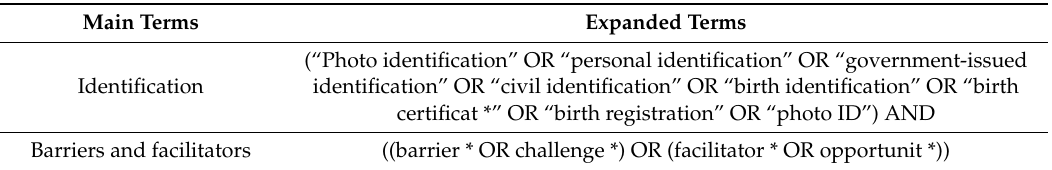
Table 1. Search strategy to identify peer-reviewed articles on barriers and facilitators to obtaining